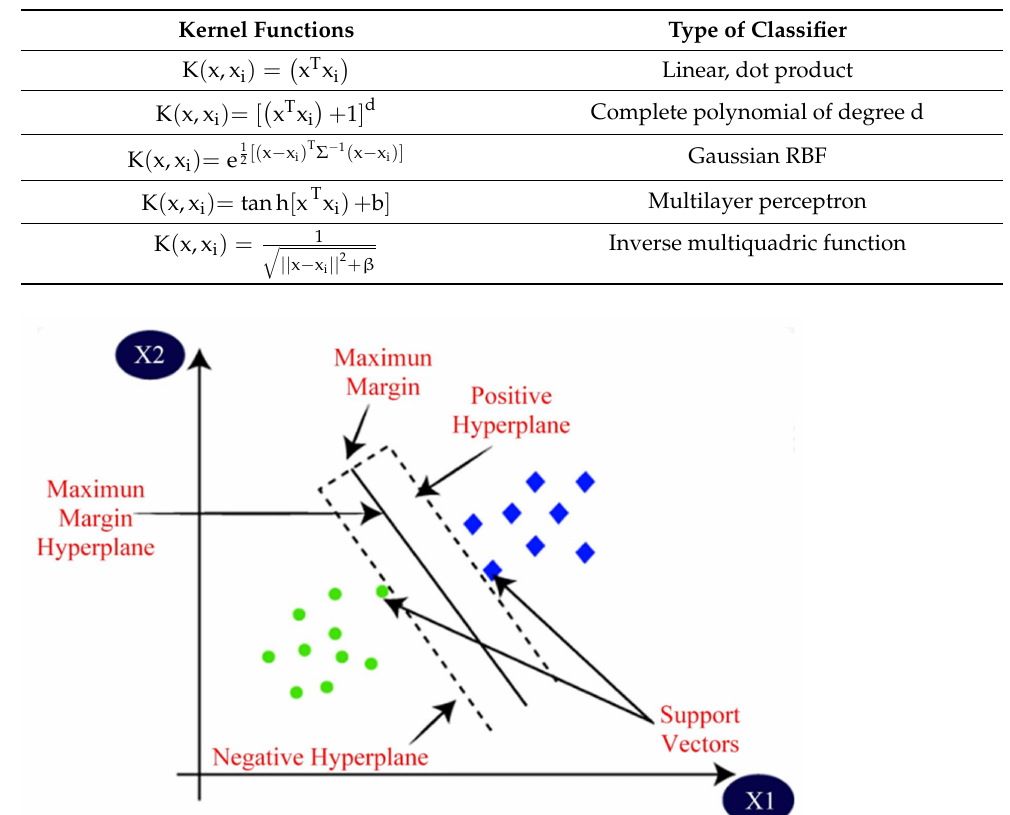
Figure 3. The 2-D illustration of the support vector machine algorithm